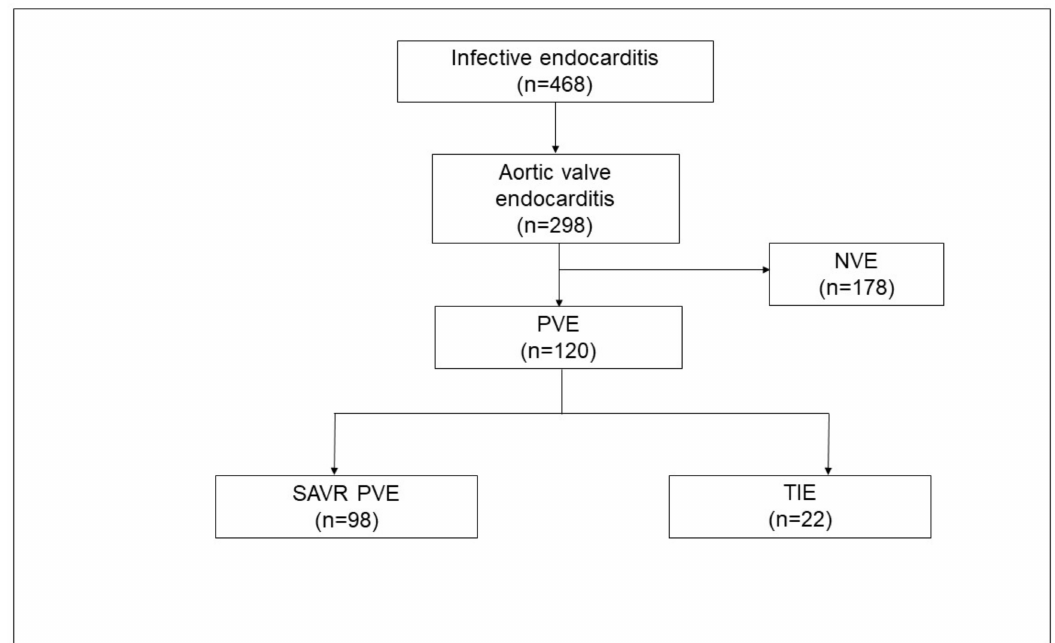
Figure 1. Case load of infective endocarditis from January 2013 to December 2020. NVE, native valve endocarditis; PVE, prosthetic valve endocarditis; SAVR–PVE, prosthetic valve endocarditis following surgical aortic valve replacement; TIE, prosthetic valve endocarditis following transcatheter aortic valve replacement.